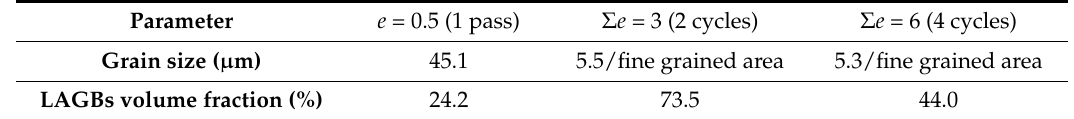
Table 2. The EBSD data of IMF-proceeded samples at 400 ◦